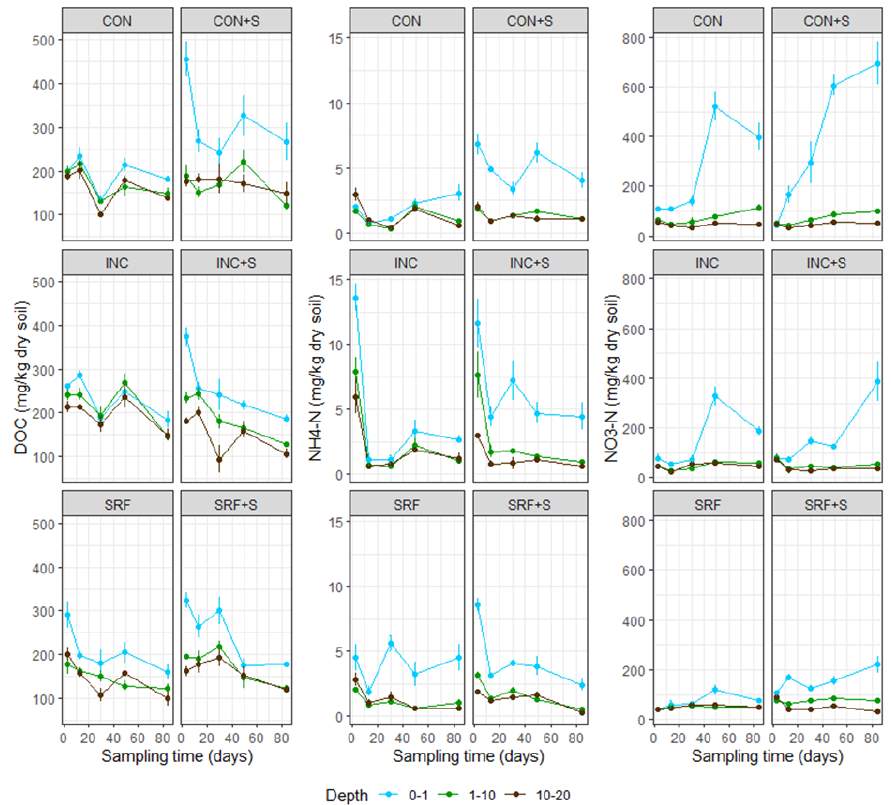
Figure 2. Dynamic of dissolved organic carbon (DOC) and mineral nitrogen forms (NH 4 -N, NO 3 -N) in CON (control), INC (straw incorporated in 0–10 cm soil layer) and SRF (straw applied at the soil surface) soil treatments in presence/absence of slurry (S) at three sampling depths (cm). Averages and standard errors of 4 replicates are shown. In the initial phase of the experiment, soil NH 4+ concentration was the highest in treat- ments with incorporated straw (INC and INC + S) at all sampling depths (Figure 2). Af- terward, it first decreased continuously till day 13 and later remained almost constant. Slurry fertilization generally increased NH 4+ concentration in the uppermost 1 cm of the soil, whereas lower soil layers were less affected. The exception is SRF, where slurry did not affect NH 4+ concentration in the 0–1 cm soil layer. Similarly to NH 4+ , NO 3- concentrations showed the largest response for the 0–1 cm soil layer. Here, NO 3 - increased over time in all treatments, both with and without slurry fertilization, except SRF. The highest NO 3- increase was observed in CON with and with- out slurry. We also observed an increasing trend in NO 3 - concentration at 1–10 cm depth in CON with and without slurry, while concentrations in the other soil treatments at 1–10 cm and 10–20 cm depth remained almost constant throughout the experiment (Figure 2).